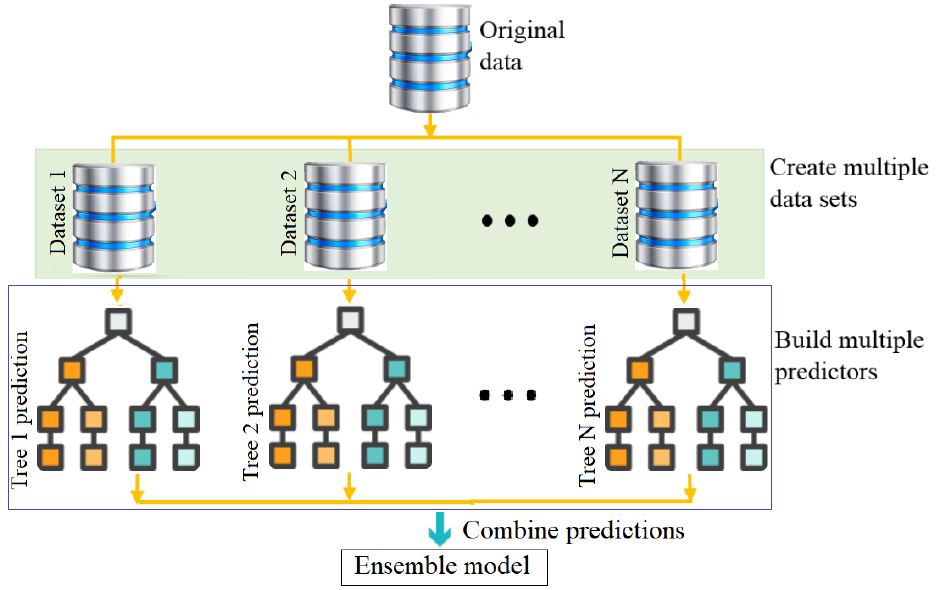
Figure 3. Schematic drawing of the concept of the BG model. Algorithm 1 below summarizes the main steps to calculate the bagging trees prediction. Algorithm 1: Bagging trees